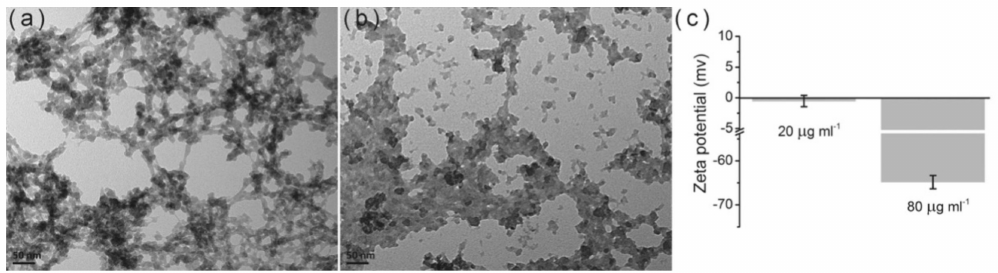
Figure 3. Effect of amino acid concentration on HAP particles: ( a ) low concentration; ( b ) high concentration. ( c ) zeta potential of the nanoparticles. With permission from Elsevier. https://doi.org/10.1016/j.jcrysgro.2020.125991 (accessed on 1 March